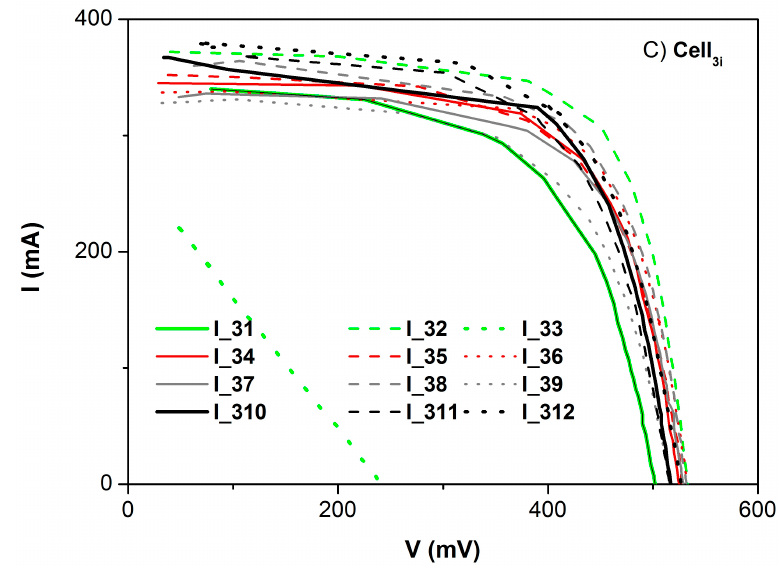
Figure 19. Manual IV of cells in string ( A ) 1, ( B ) 2 and ( C ) 3. The irradiation (not calibrated) is the same for all the cells.